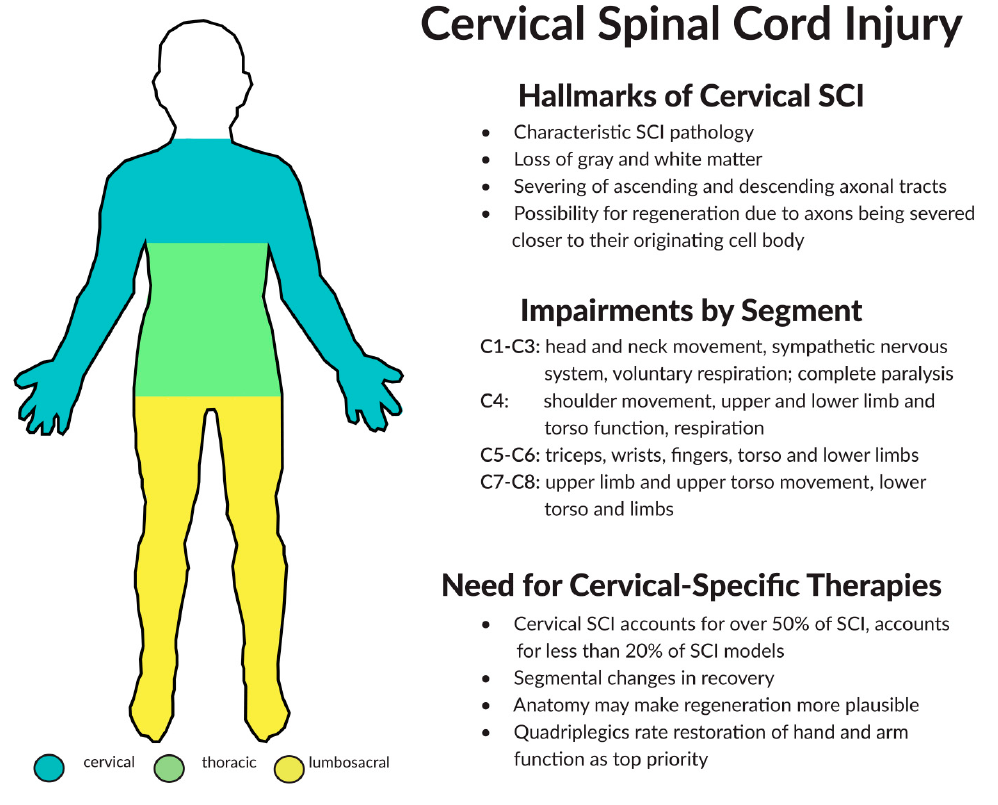
Figure 1. Clinical deficits, segmental differences, and the need for cervical-specific therapies for Spinal Cord Injury (SCI) within the human.